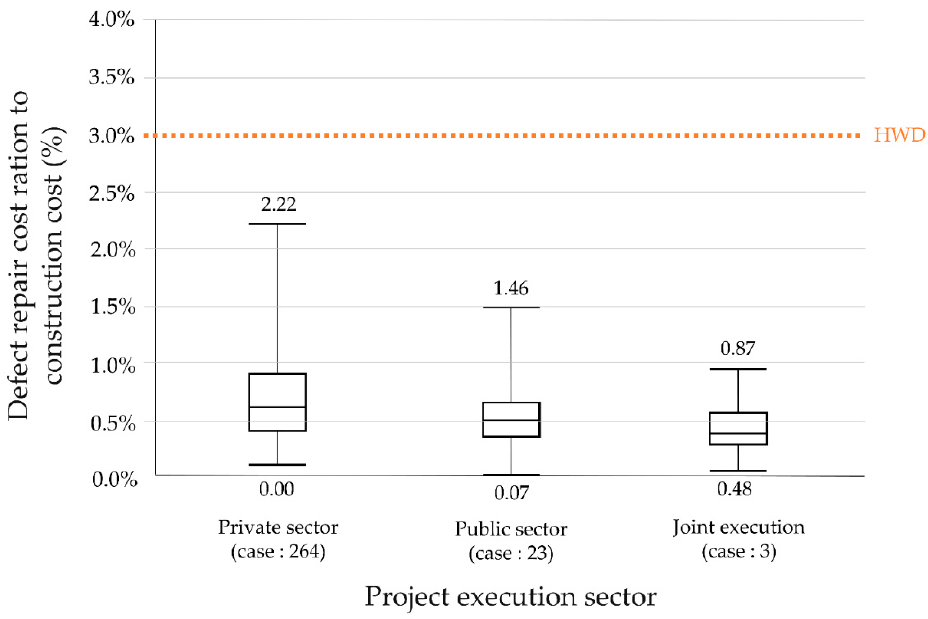
Figure 6. Comparison of project execution sector.